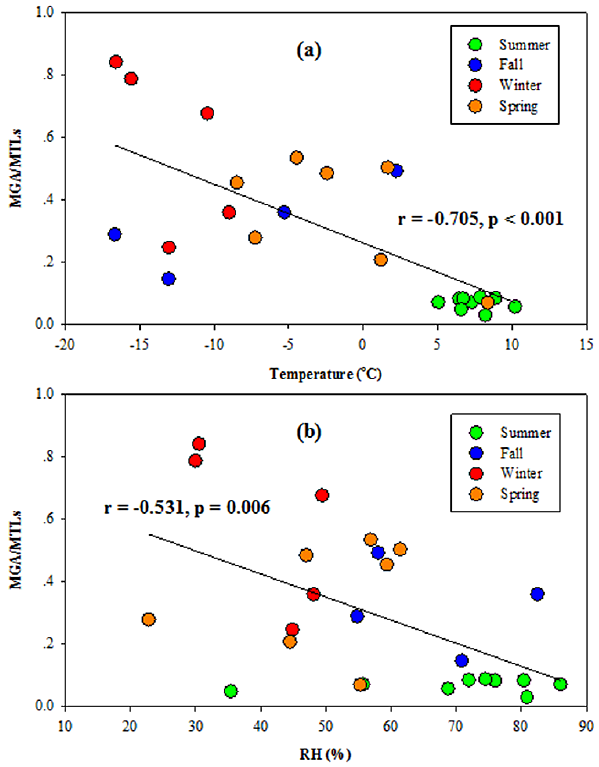
Figure 4. Correlations of MGA/MTL with temperature (a) and rela- tive humidity (b) . Summer is from July to September 2012 and from June to July 2013, fall is from October to November 2012, winter is from December 2012 to February 2013, and spring is from March to May 2013.